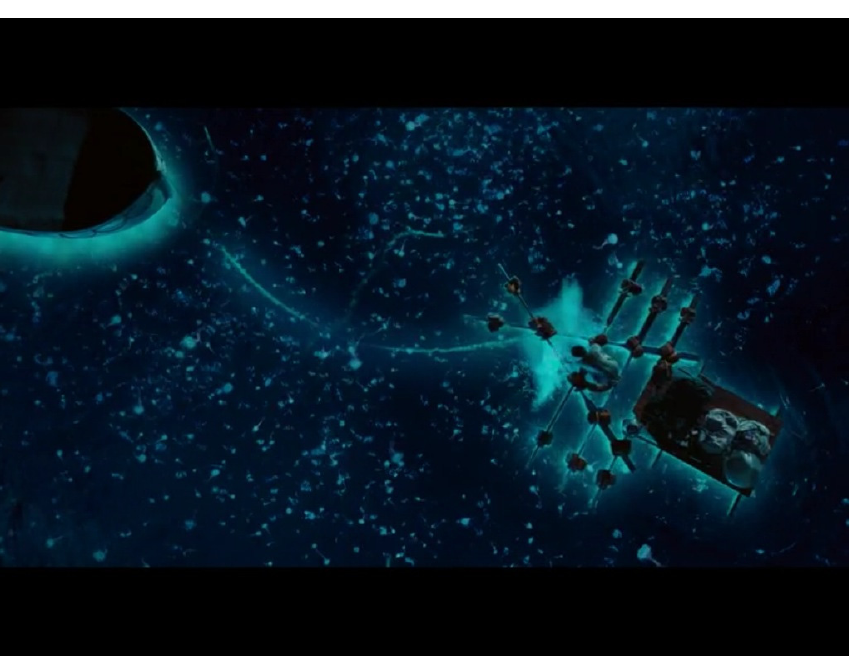
Figure 17. Pi peers into the ocean, where sea creatures function as points of light in an abyss.